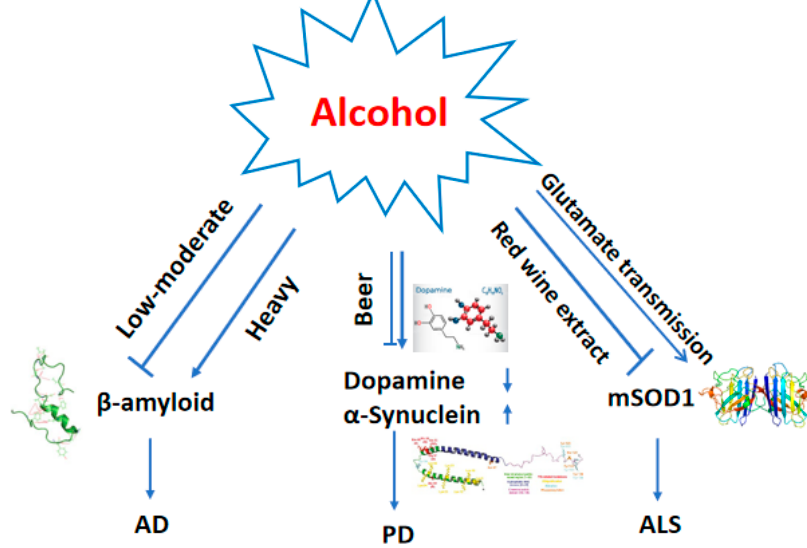
Figure 2. Dual roles of alcohol drinking in Alzheimer’s disease (AD), Parkinson’s disease (PD) and Amyotrophic lateral sclerosis (ALS). In AD, low or moderate concentrations of ethanol protect against the damage induced by A β . Excessive amounts of ethanol increase accumulation of A β and Tau phosphorylation [35]. In PD, most studies show that alcohol decreases levels of DA and increases the levels of α SYN. One study suggested that the high drinking alko alcohol (AA) rats showed lower stimulated DA levels and more e ffi cient DA re-uptake in the nucleus accumbens core than the low drinking non-alcohol (ANA) rats did. In the same structure, AA rats also had significantly higher levels of α -syn. No di ff erences were found in the e ff ects of two di ff erent doses of ethanol (0.1 and 3.0 g / kg) [42]. A meta-analysis concluded that beer, but not wine and liquor, probably protected against PD [36]. In ALS, red wine extract intake was reported to prolong the lifespan of mSOD1-transgenic mice and protected neurons from apoptosis in vitro. There is a dysfunction of the glutamatergic excitatory system in ALS, and chronic alcohol intake involves changes in glutamatergic transmission. The association between alcohol and ALS is still unclear. Abbreviations: A β : β -amyloid; DA: Dopamine; mSOD1: Mutated